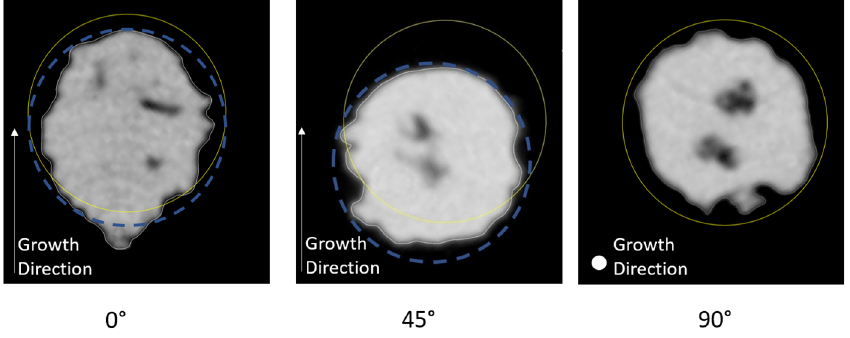
Figure 9. X-ray images of cross-section variation with orientation and comparison with the